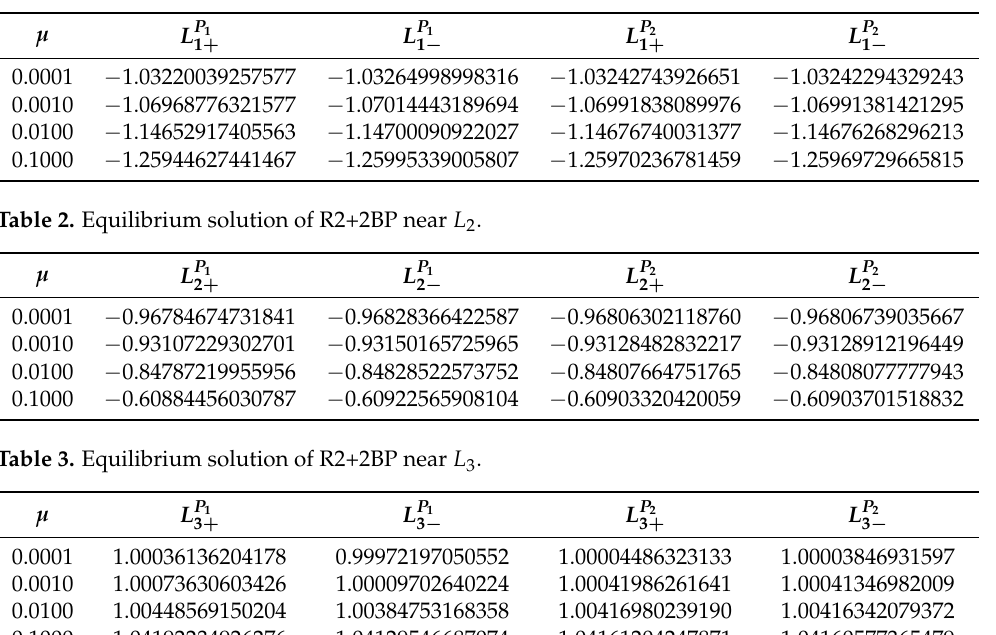
Table 1. Equilibrium solution of R2+2BP near L 1 .